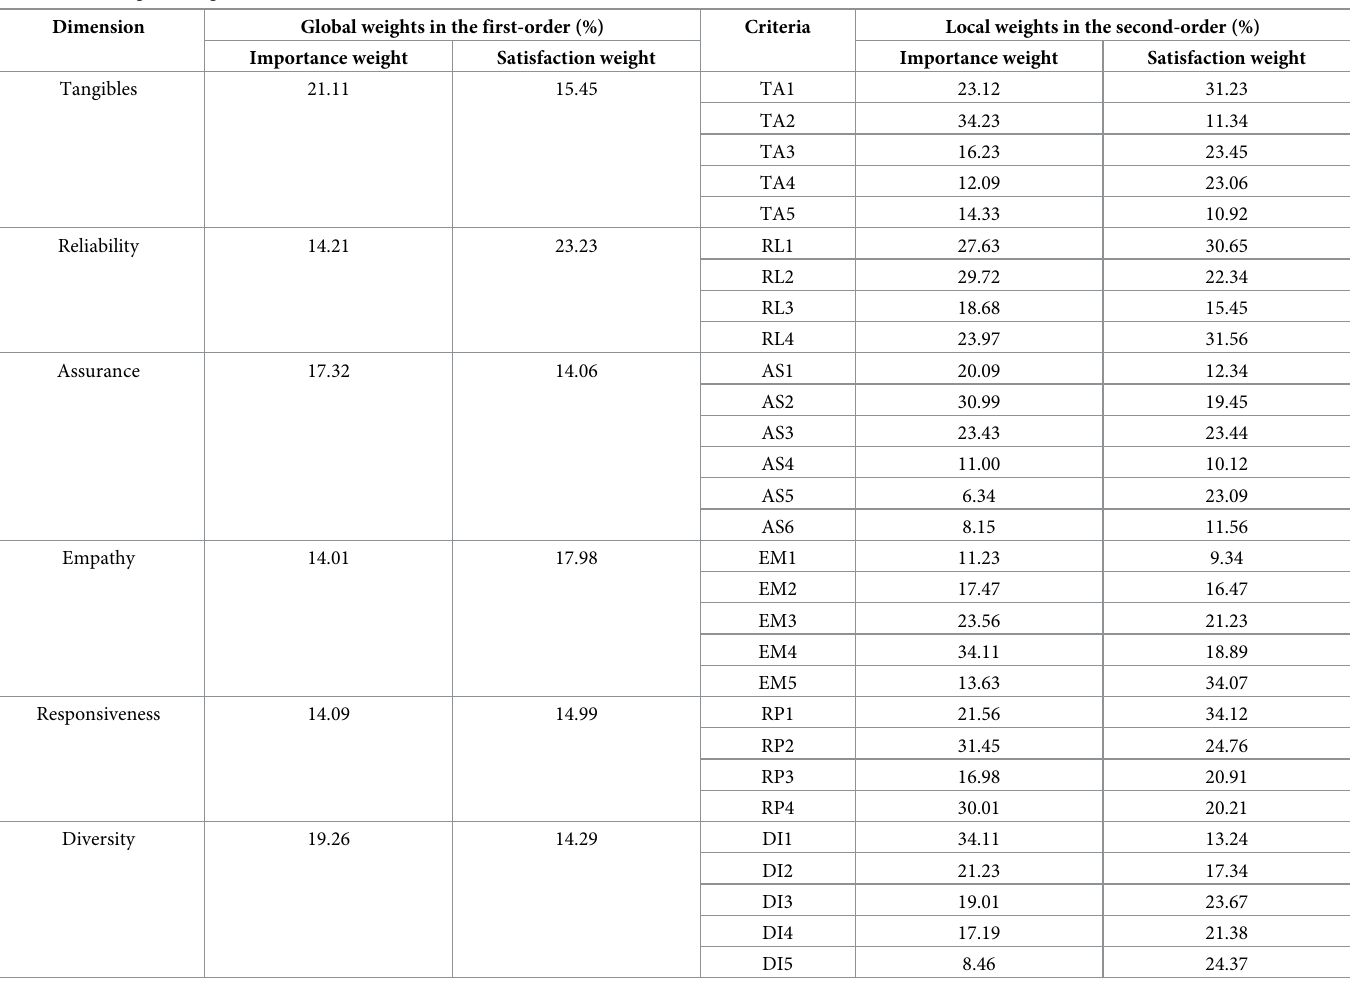
Table 7. The original weights for